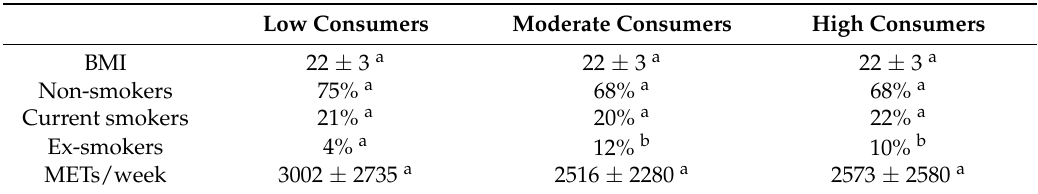
Table 2. BMI, smoking habits and physical activity in low, moderate and high cocoa consumers. Results are expressed as mean ± SDM or ratio. Different letters mean statistical